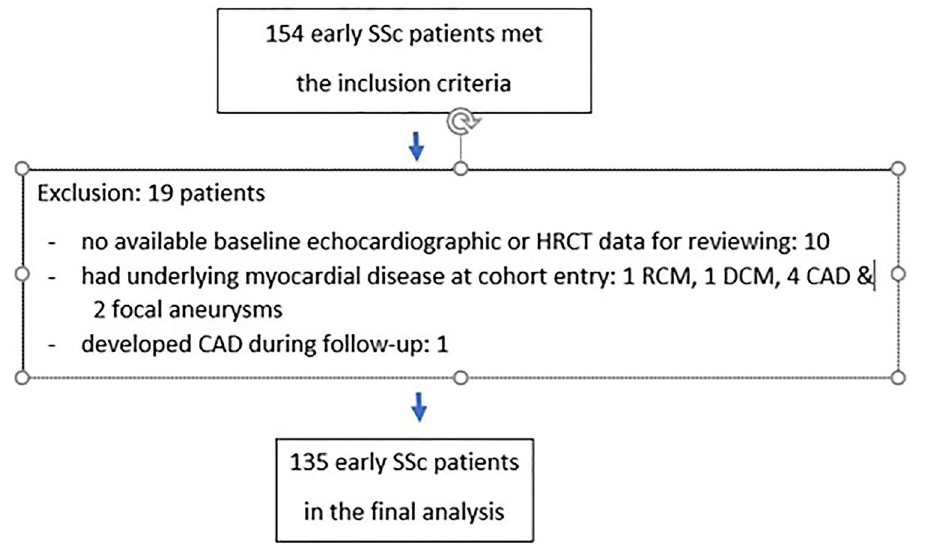
Figure 1. Flow diagram of study